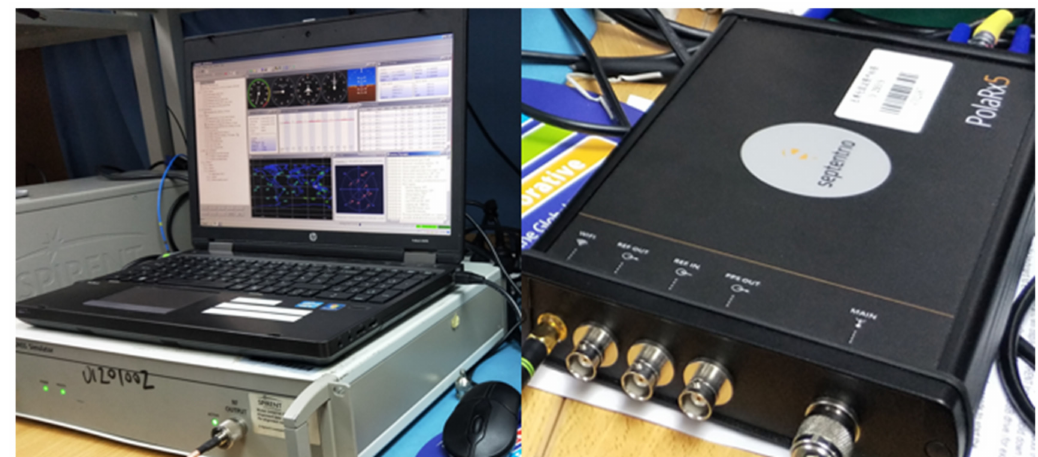
Figure 5. Experimental platform setup.